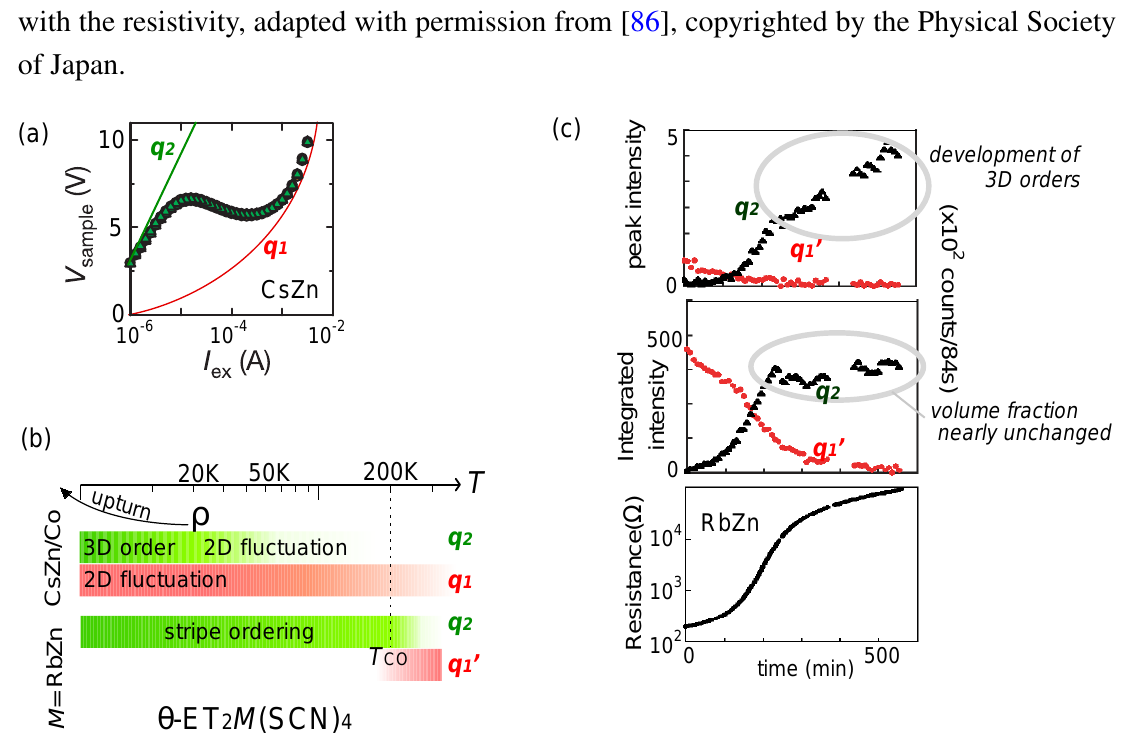
CsZn(SCN) , adapted with permission from [83]; 2 4 , q (cid:48) and q peaks of CsZn/Co and RbZn salts; ( c ) 1 2 1